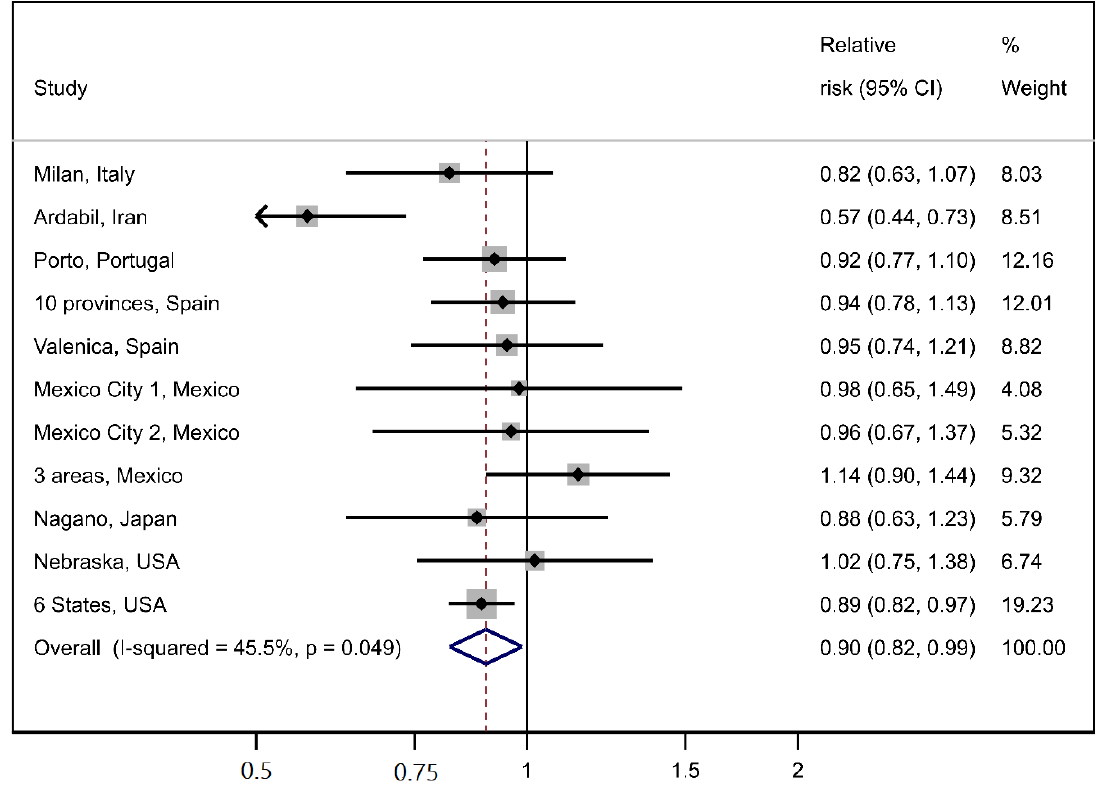
Figure 1. Interactions between iron and tobacco smoking and iron and salt intake — iron intake is categorized above (reference category) vs. below median intake. Odds ratios adjusted for study, sex,